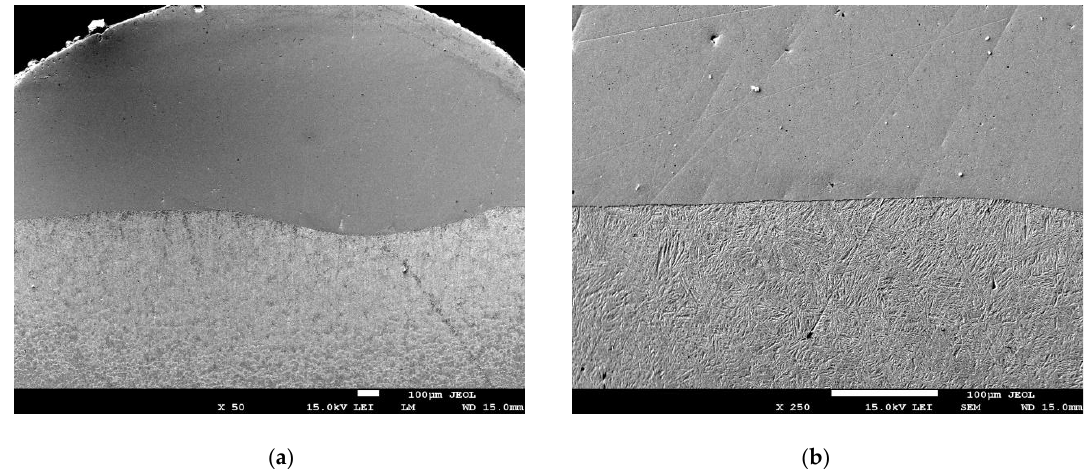
Figure 7. SEM images of Ni-20Cr+Re deposit ( a ) and interface ( b ) obtained by laser cladding at the power of 2400 W. Figure 8 shows the analysis of the distribution of elements in the area of the clad (marked with a rectangle in Figure 8f) for samples obtained at all laser power values from 1500 to 2700 W. The position of the EDS measurement was set at a distance of around 120 μm from the interface at the clad side. In all samples, the analysis shows the content of Rhenium in the clad in the range of 0.8–0.9%. The proportion of nickel and chromium gradually decreases with increasing laser power from 77.5% to 52.2% at the highest power. This decrease is accompanied by an increase in the proportion of iron from the steel sub- strate to 33.5% for the highest power. From the point of view of the service properties of the tested layers, the proportion of iron in the clad should be as low as possible while maintaining the appropriate dilution and clad shape. For this reason, the clad obtained for a laser power of 2400 W was selected for further microstructure investigation. ( a )